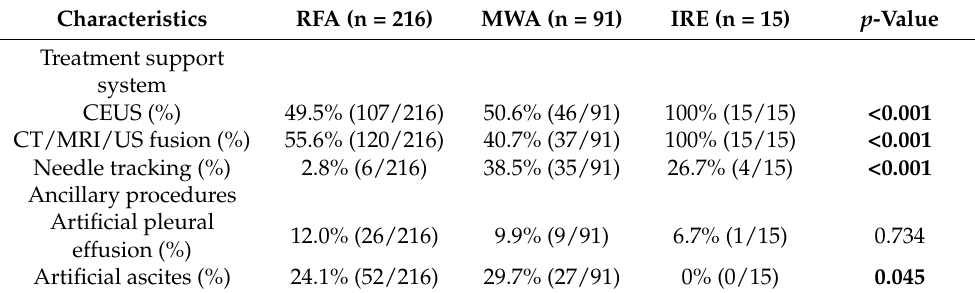
Table 3. Ancillary procedures according to three different ablation